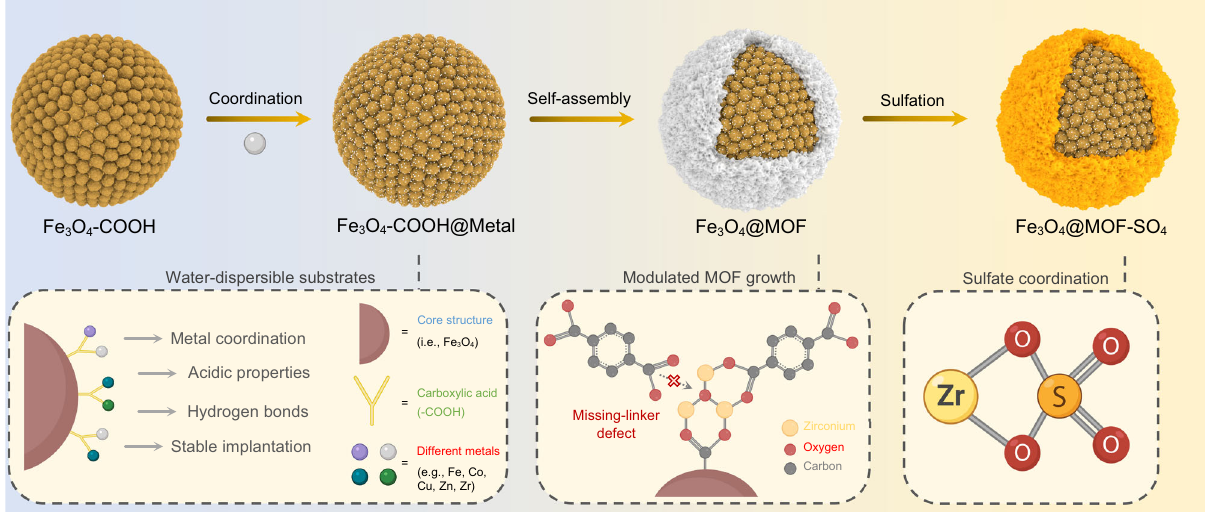
Fig. 1 Synthetic strategy for engineering water-dispersible nanocatalysts. Schematic illustration of sulfated core – shell nanomaterials through modulated self-assembly of MOFs on the carboxylate-rich surface of Fe 3 O 4 – COOH nanoclusters. The acidic cover of magnetic nanocluster enables the creation of missing-ligand defects in the assembled structure and forms a hierarchical micro-mesoporous network. The coordination of chelating sulfate on metal clusters results in the formation of water-dispersible nanocatalysts with superacidity.